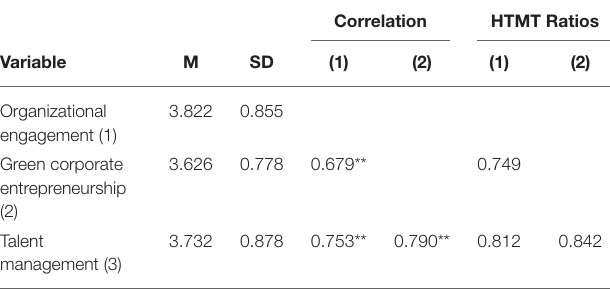
TABLE 3 | Descriptive statistics and discriminant